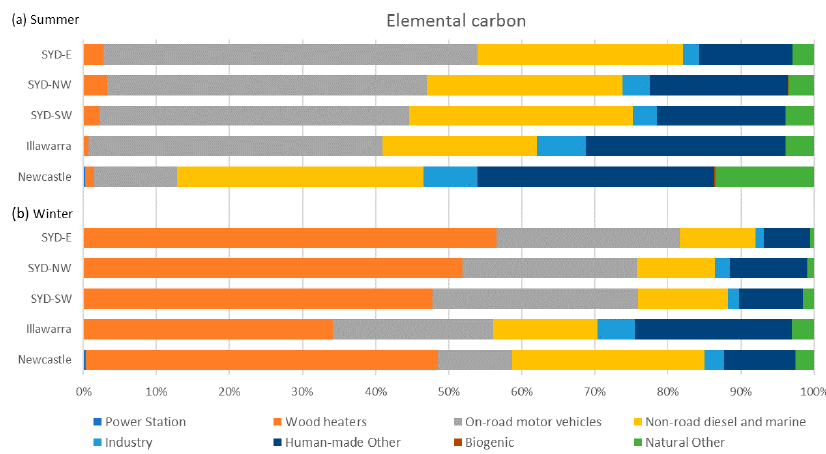
Figure 10. Regional average major source groups contribution (%) to elemental carbon mass in the Sydney East (SYD-E), Sydney Northwest (SYD-NW), Sydney Southwest (SYD-SW), Illawarra and Newcastle regions in ( a ) summer and ( b ) winter of 2008.